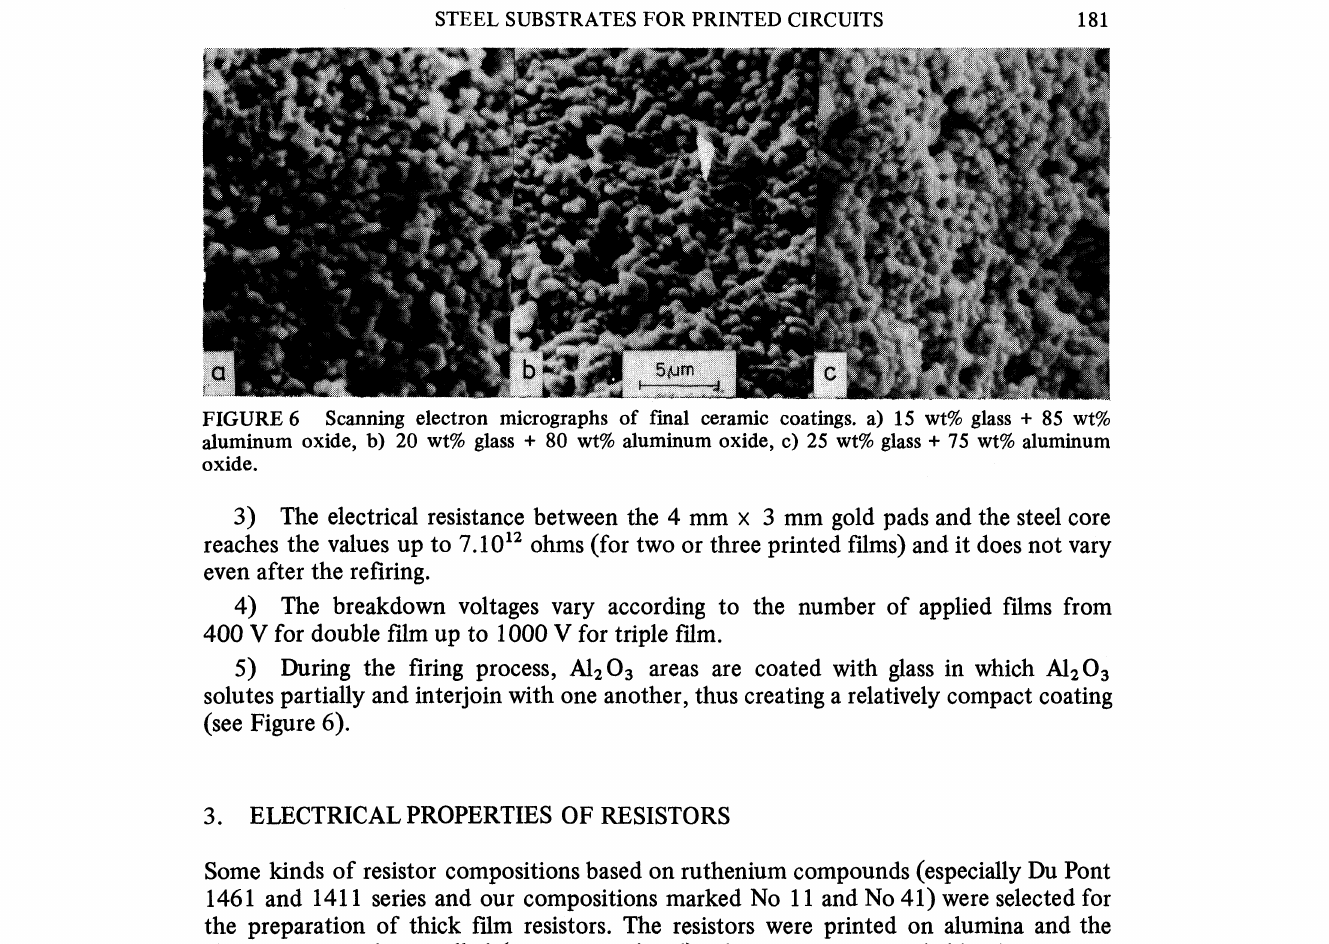
FIGURE 6 Scng electron micrographs of Final ceramic coatgs, a) 15 wt% glass + 85 wt% umum oxide, b) 20 wt% glass + 80 wt% aluminum oxide, c) 25 wt% glass + 75 wt% alumum